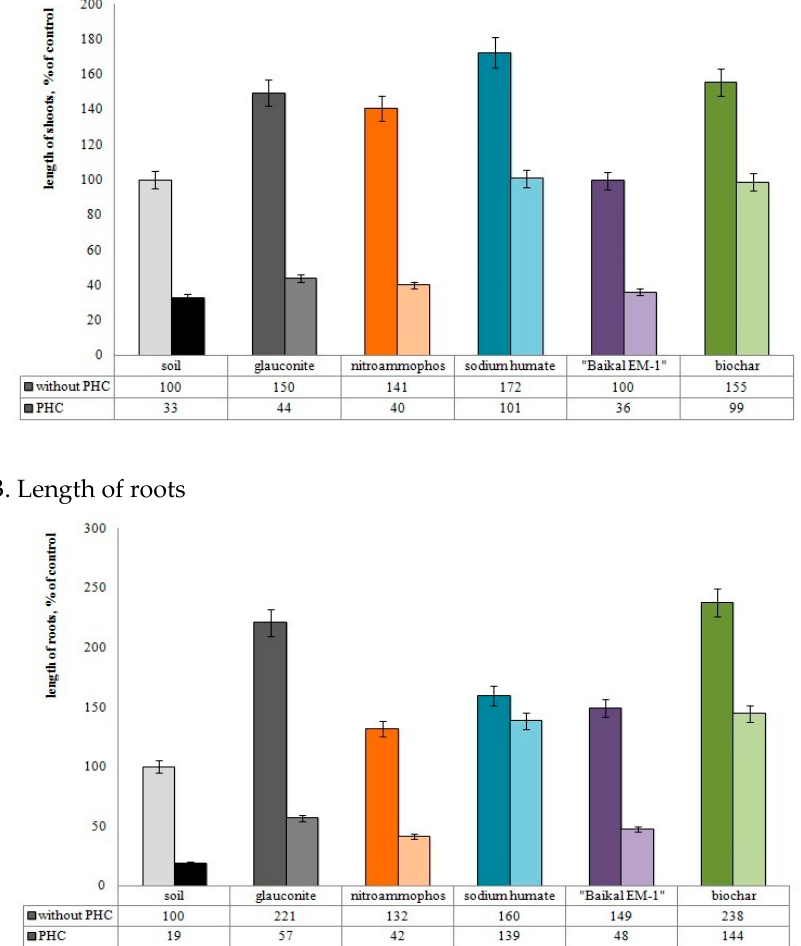
Figure 12. Changes in the lengths of shoots ( A ) and roots ( B ) of radish in non-contaminated and petroleum hydrocarbon-contaminated Haplic Chernozem Calcic soil after adding various bioremediators, mm. Note: PHC, petroleum hydrocarbon.